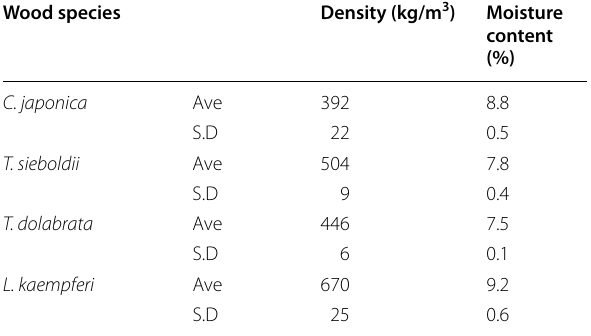
Table 2 Basic properties of embedment test